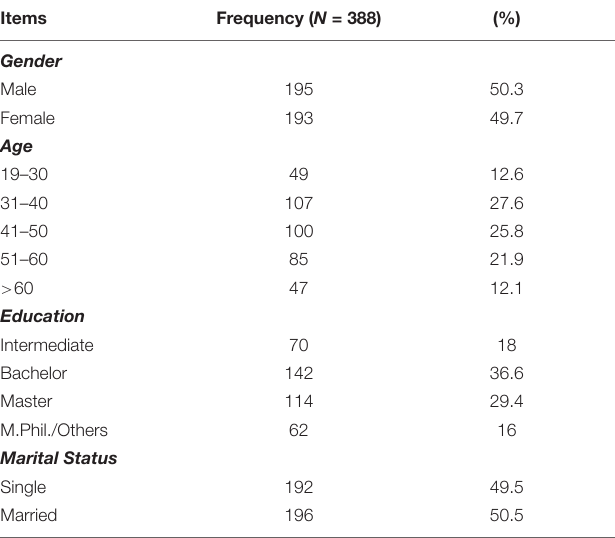
TABLE 1 | Demographic characteristics.